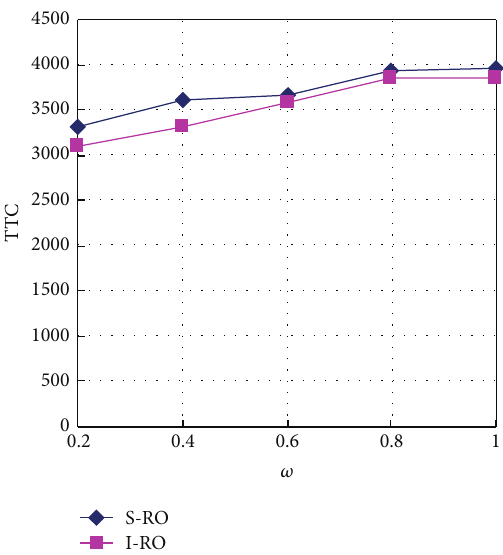
Figure 5: Variation in TTC with different 𝜔 values.